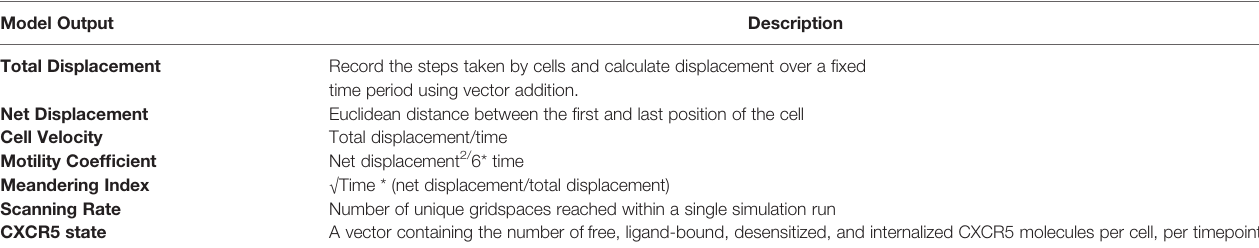
TABLE 1 | Summary of model